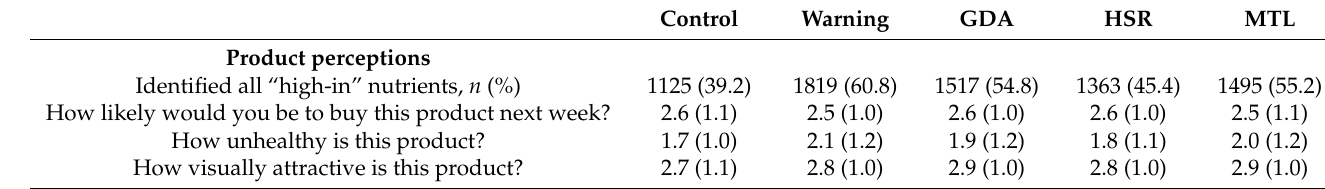
Table A2. Descriptive statistics for the product and label assessment outcomes by